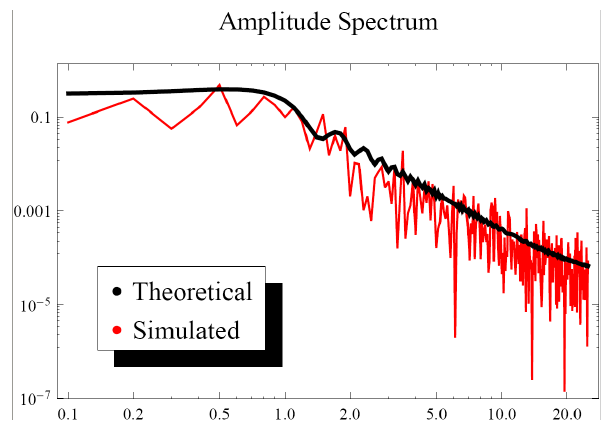
Fig. 4. Amplitude frequency spectrum (in Hz) for theoretical and simulated